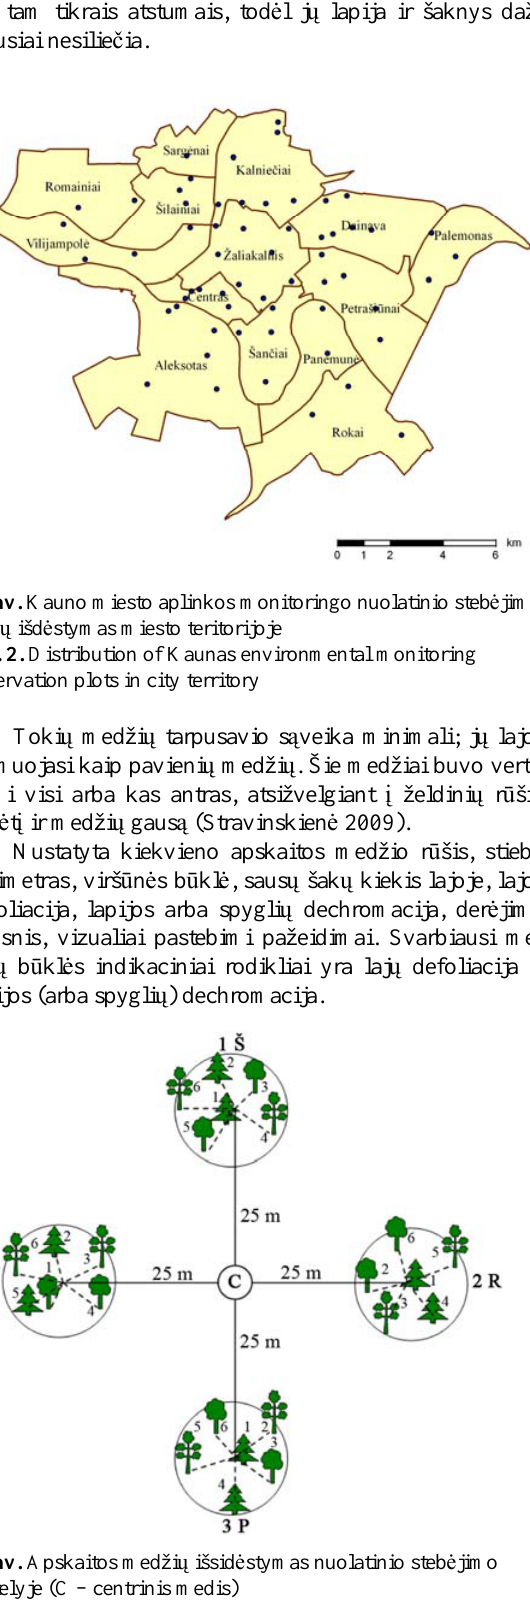
Fig. 3. Distribution of sample trees on permanent observation plot (C – central